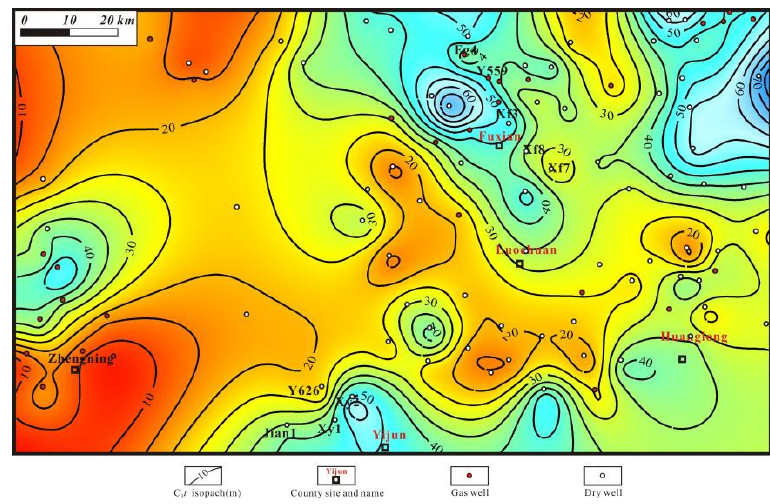
Figure 11. Stratigraphic isopach map of the Taiyuan Fm. in the southeastern Ordos Basin.